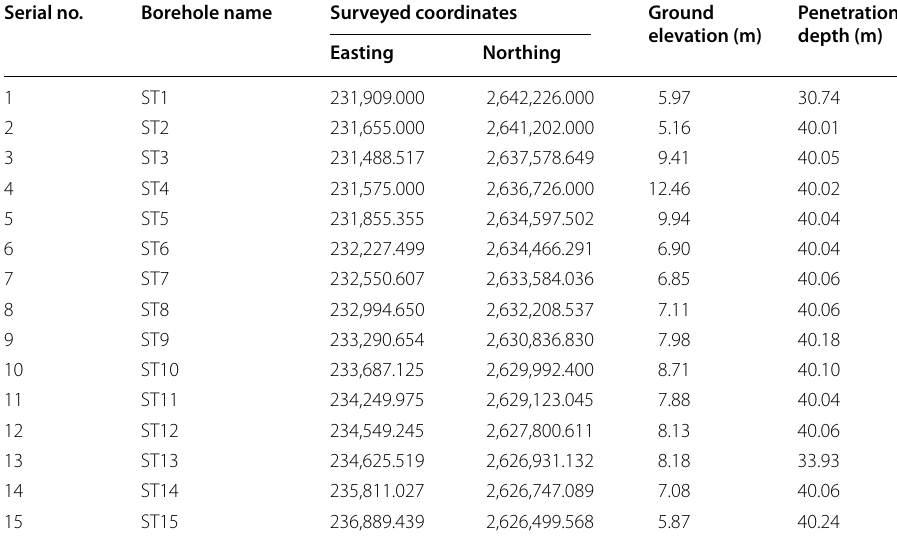
Table 1 Bore log location of SPT and CPT Serial no.